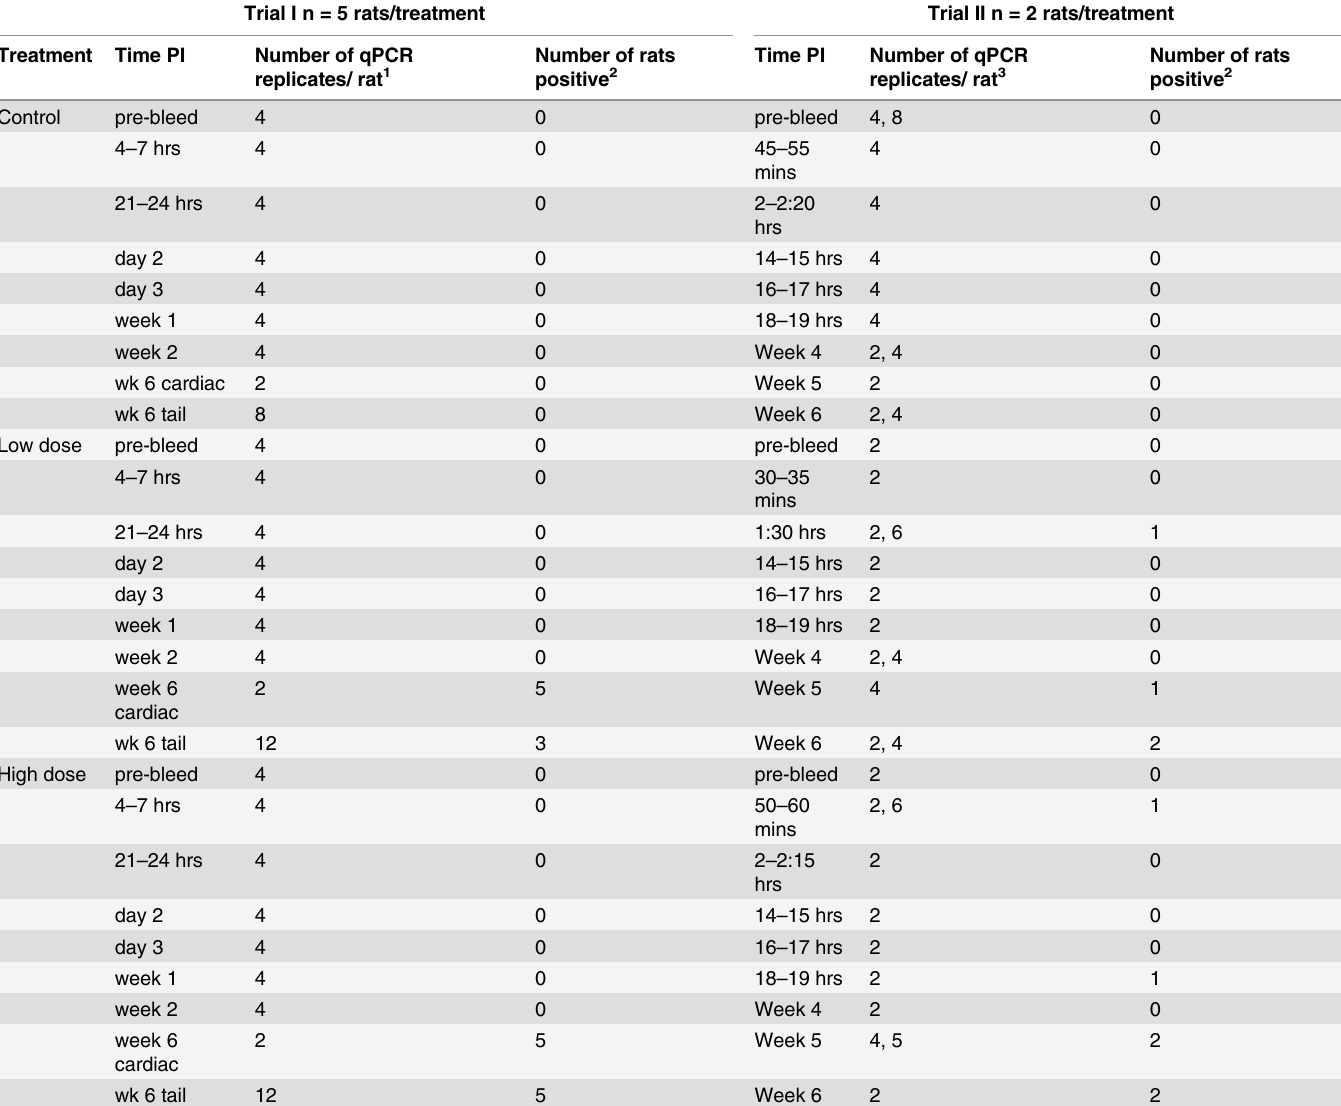
Table 2. Results of qPCR for detection of RLW DNA in blood or tissue of rats involved in Trial I and Trial II. Trial I n = 5